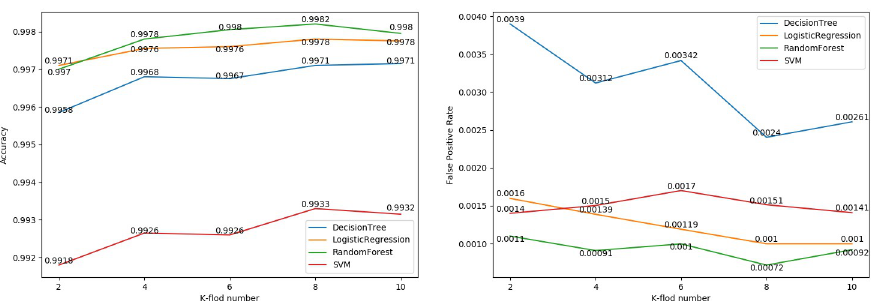
Fig 6. Comparison among the 4 different algorithms.